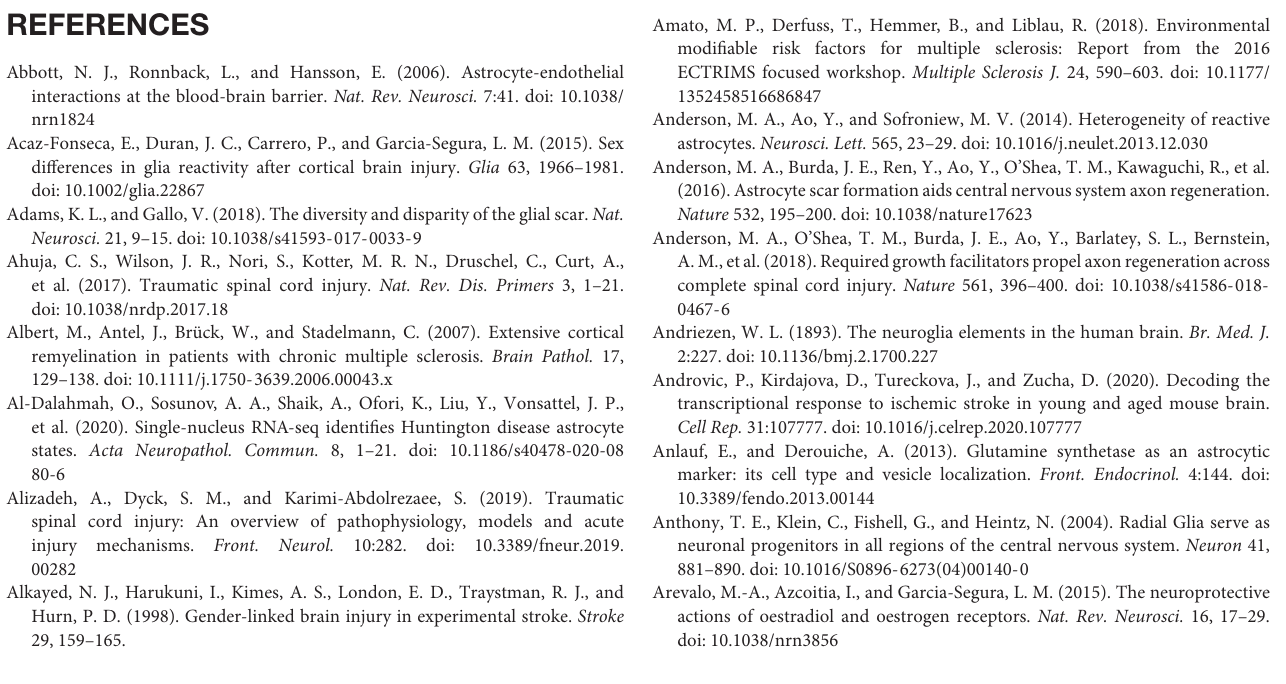
and figure preparation of the review. AJM, JWS, RJMF,